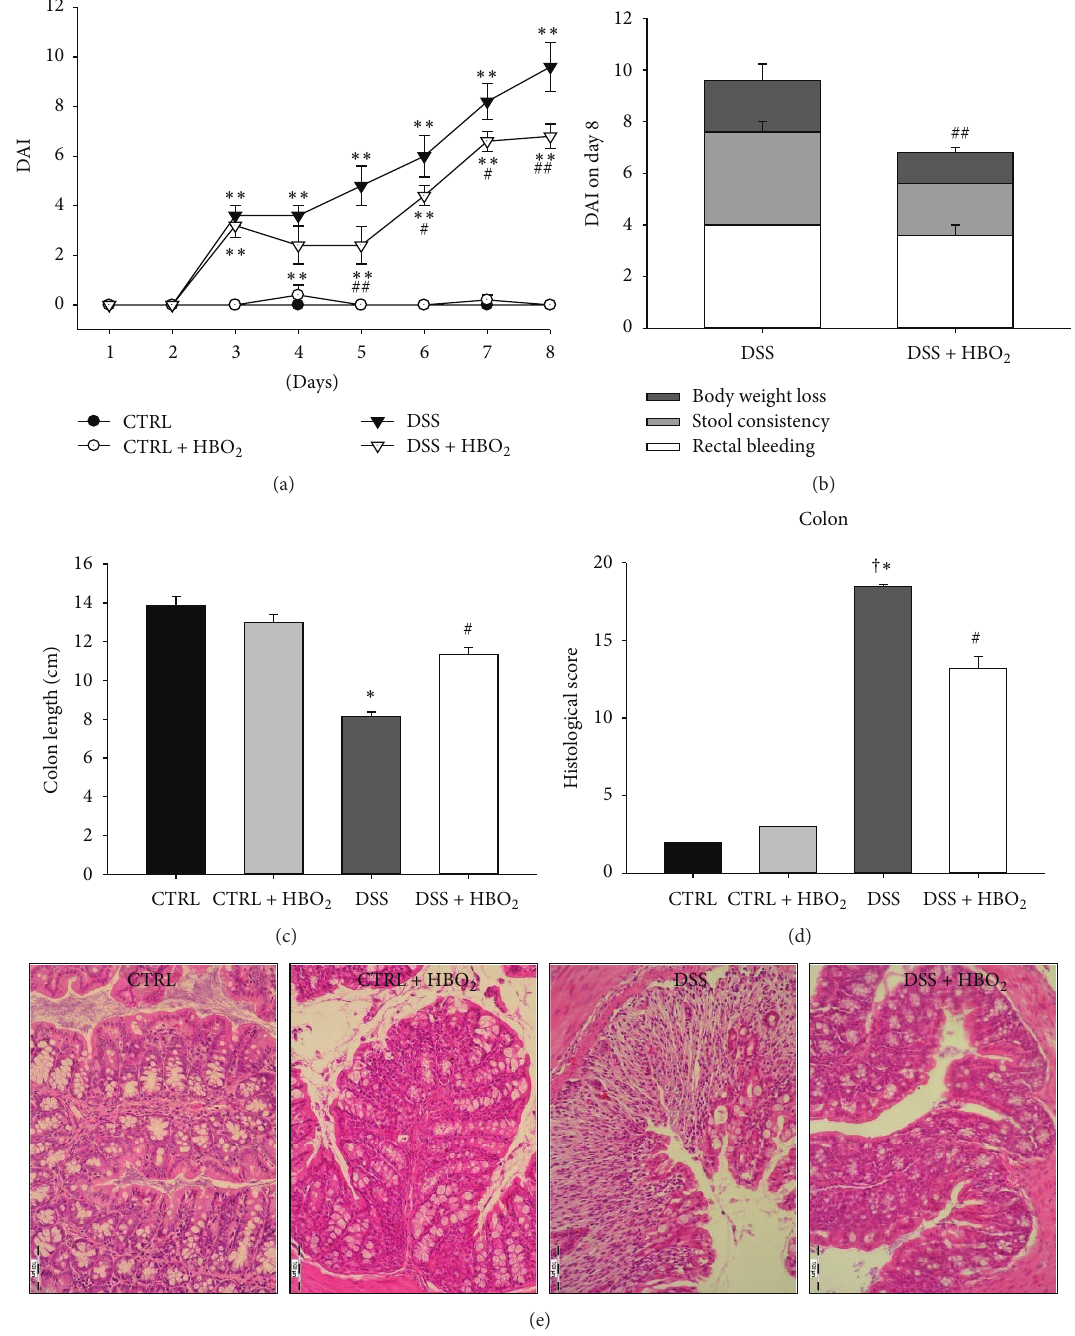
Figure 1: HBO 2 ameliorates the course of DSS-induced colitis in BALB/c mice. Male BALB/c mice at the age of 10–12 weeks